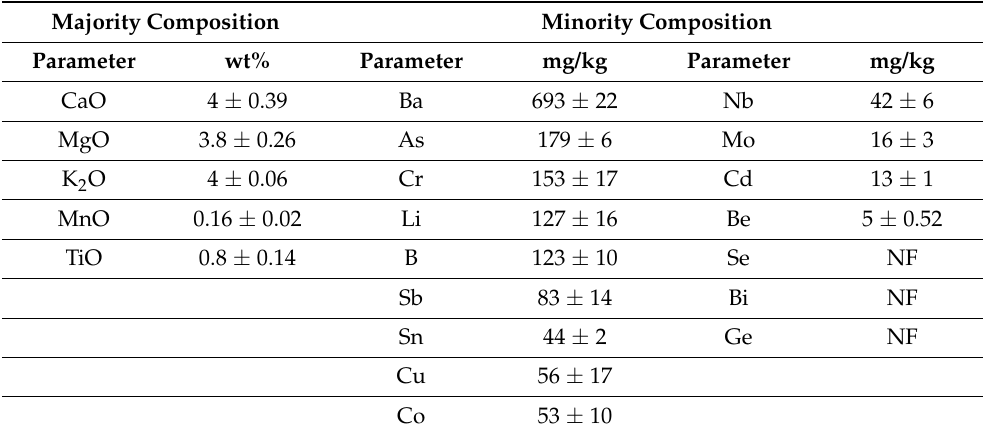
Table 3. Chemical composition of DWTS from Marrakech (Wet season).